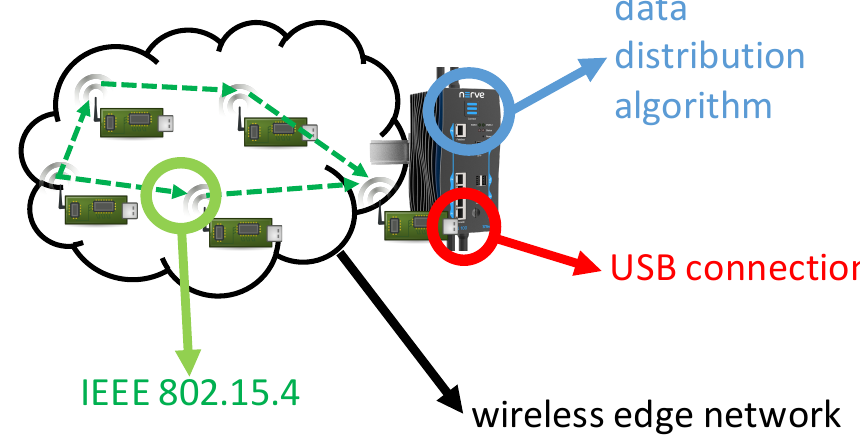
Figure 8. Second test case